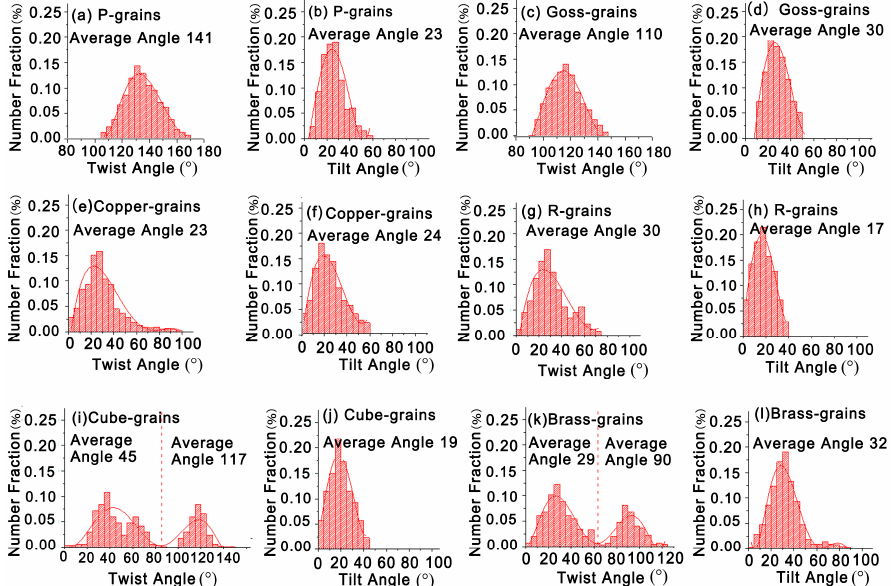
Figure 10. The twist angle and tilt angle distribution of P-grains with its neighboring grains ( a , b ); Goss-grains with its neighboring grains ( c , d ); Copper-grains with its neighboring grains ( e , f ); R-grains with its neighboring grains ( g , h ); Cube-grains with its neighboring grains ( i , j ); Brass-grains with its neighboring grains ( k , l ).